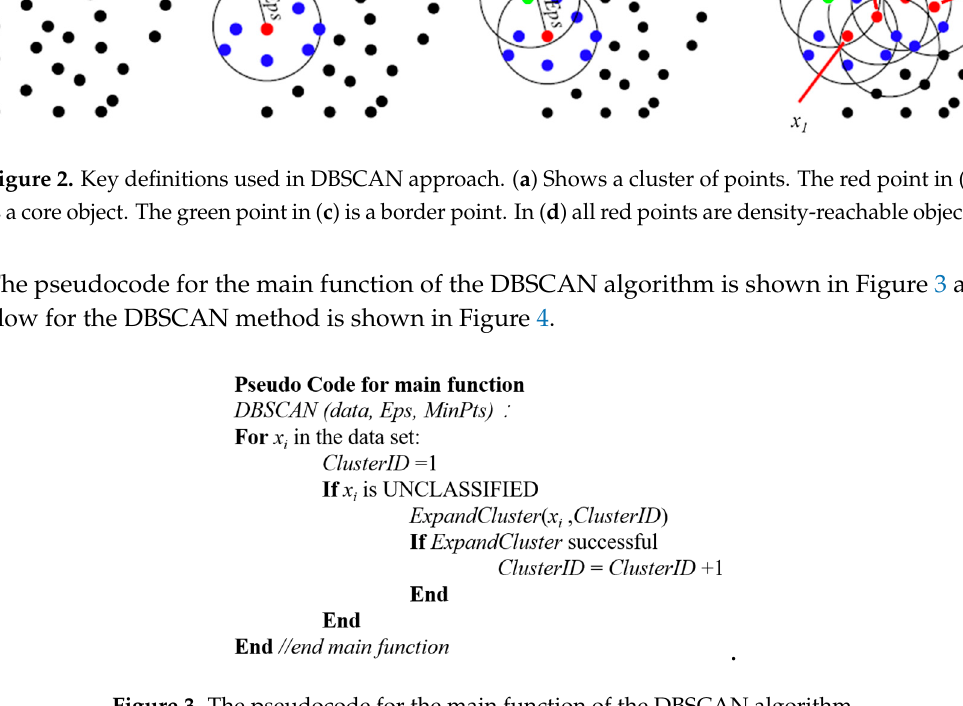
Figure 3. The pseudocode for the main function of the DBSCAN algorithm.